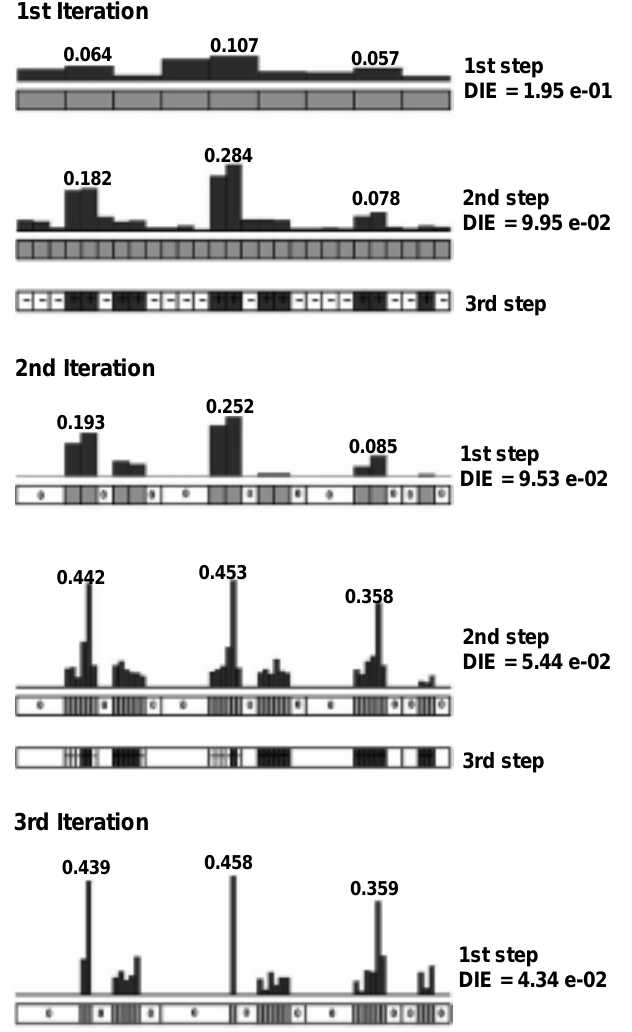
Fig. 8. Experimentally measured FRF-data based damage identification results obtained by the reduced-domain